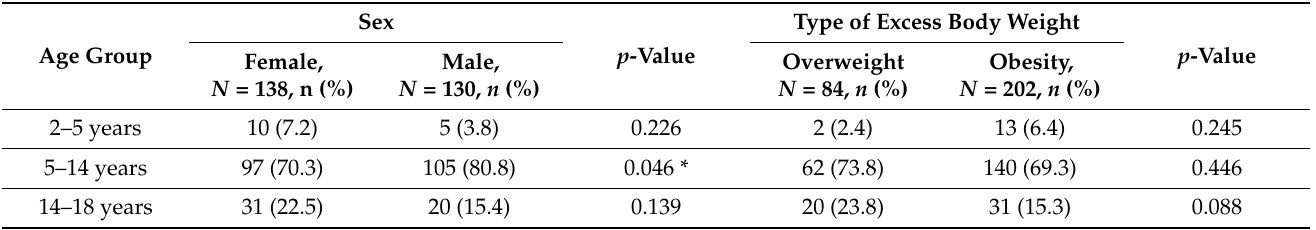
Figure 2. Lipid profile and hormonal changes in the study group. Table 2. Distribution of children by gender and type of excess body weight according to age group. Table 1. Laboratory findings in the study group.